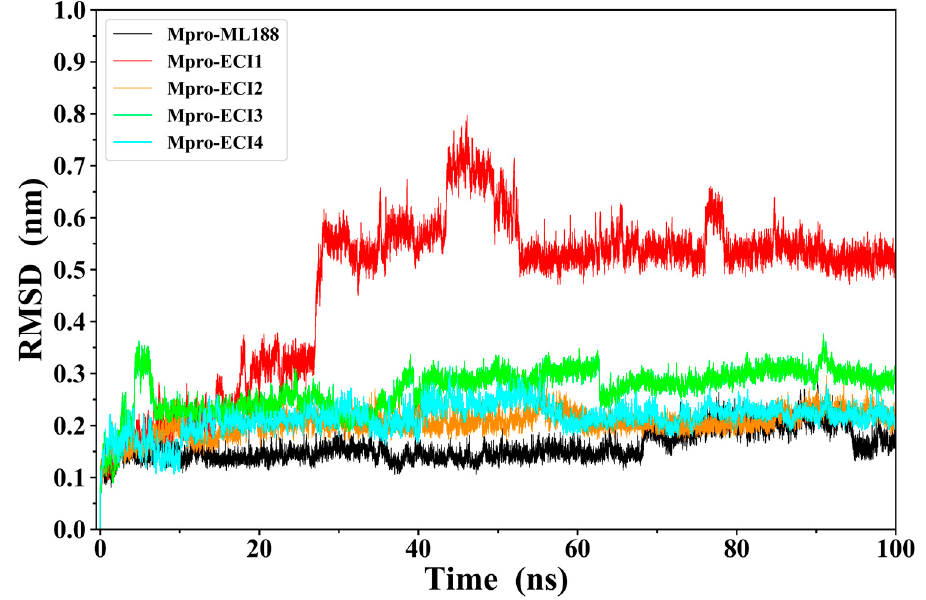
Figure 3. Time-dependent root mean square deviation (RMSD) values of Mpro C α and inhibitor heavy atoms of the five complexes with respect to their respective starting structures during the 100-ns MD simulation.